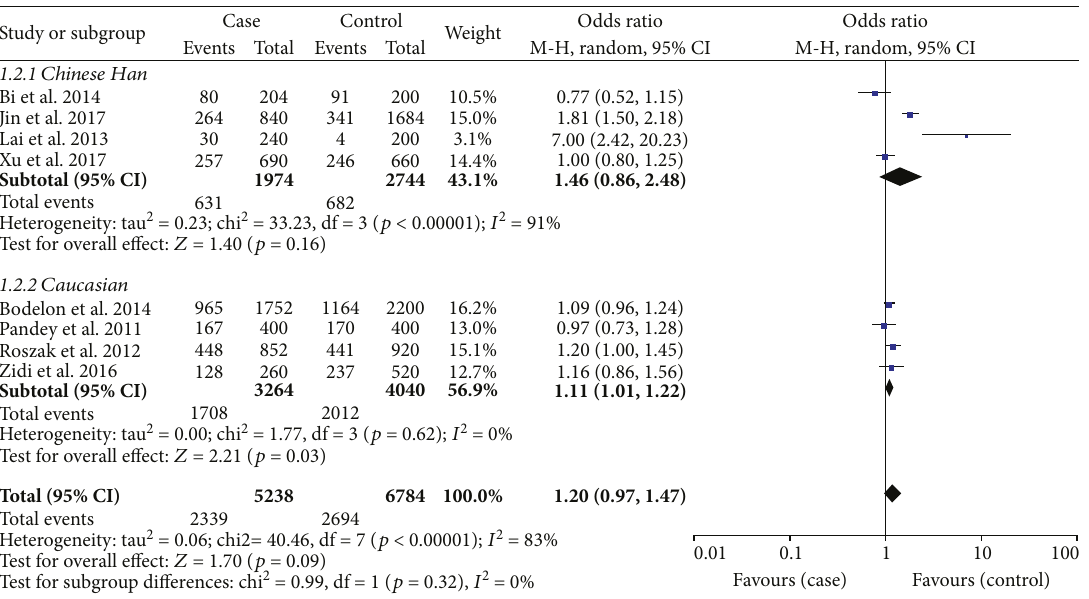
Figure 3: Subgroup analysis of the association between TLR9 rs352140 polymorphism and the risk of cervical cancer strati fi ed by race in the allele genetic